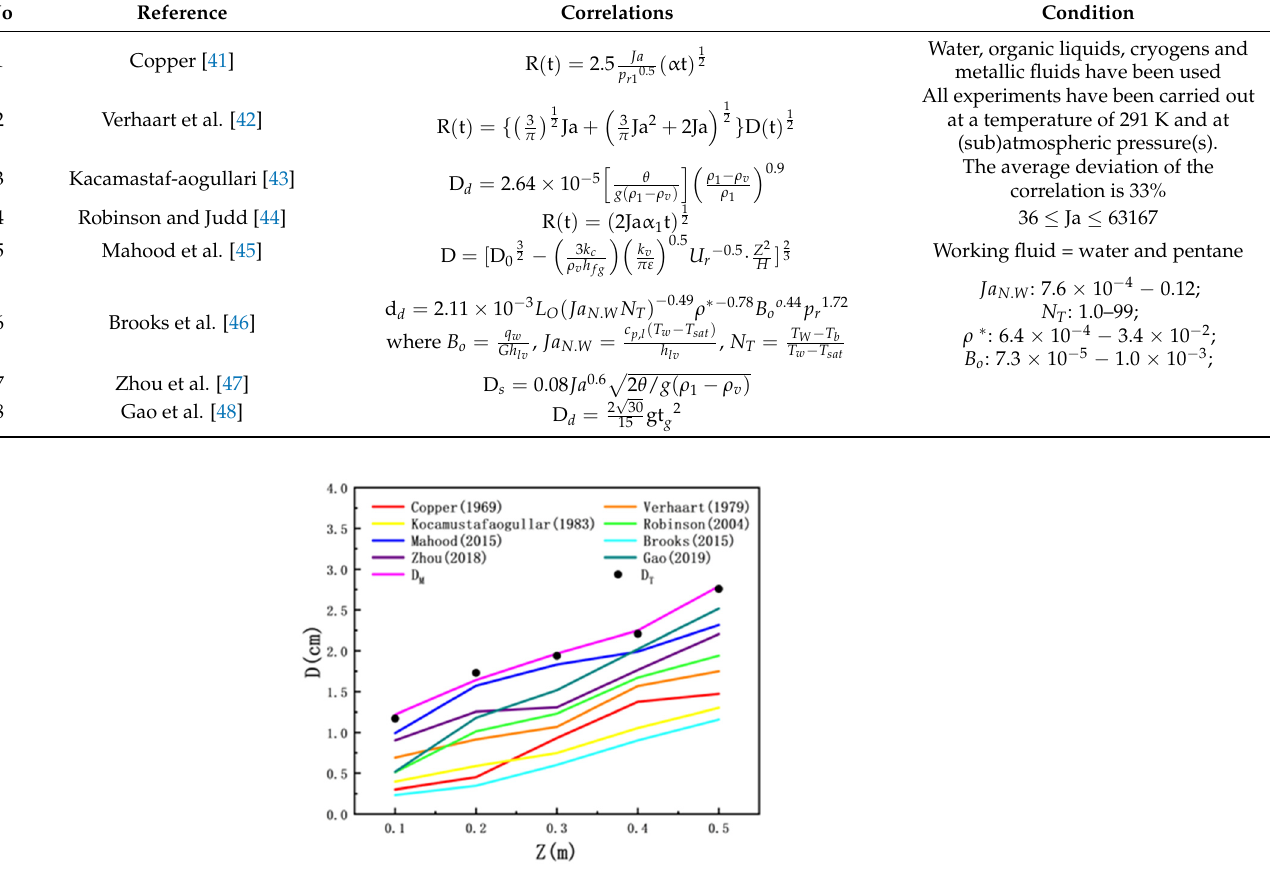
Figure 5. T c = 60 °C, m d :m c = 1:5, comparison of the bubble growth correlation proposed in this paper with experimental data and other correlations[41–48].